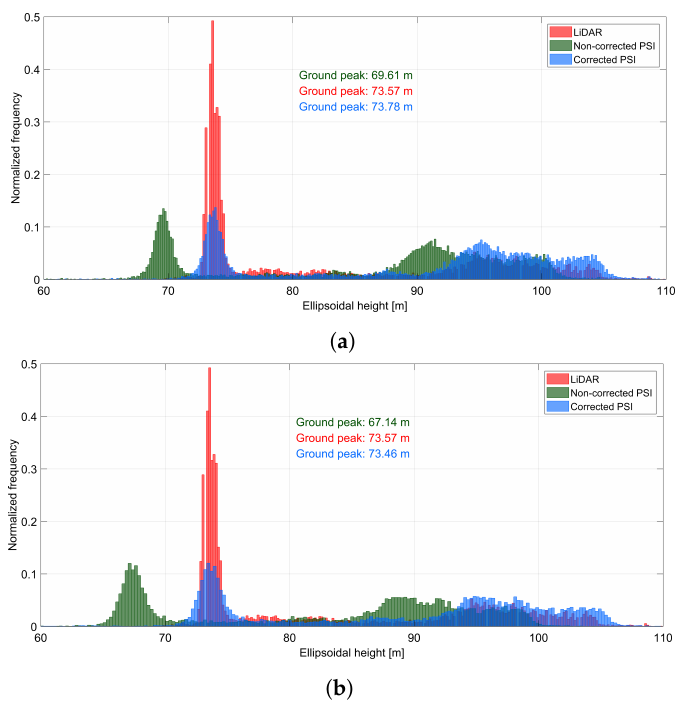
Figure 15. Ellipsoidal height histograms of non-façade points in LiDAR (red), non-corrected PSI (green) and corrected PSI point clouds (blue) corresponding to the yellow bounding box in Figure 5. ( a , b ) show the results for Beam57 and Beam42, respectively. For both beams, the height shifts are compensated for after correction, using SAR-GCPs, as the ground peaks of PSI point clouds and LiDAR data become